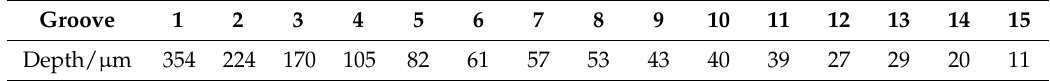
Figure 4. Schematic view of the ring specimen, not to scale. ( Top ) outer proportions of the ring; ( Bottom ) unrolled outer surface. Short vertical lines indicate the positions of the 15 grooves. Table 1. Groove depths. Labels correspond to those shown in Figure